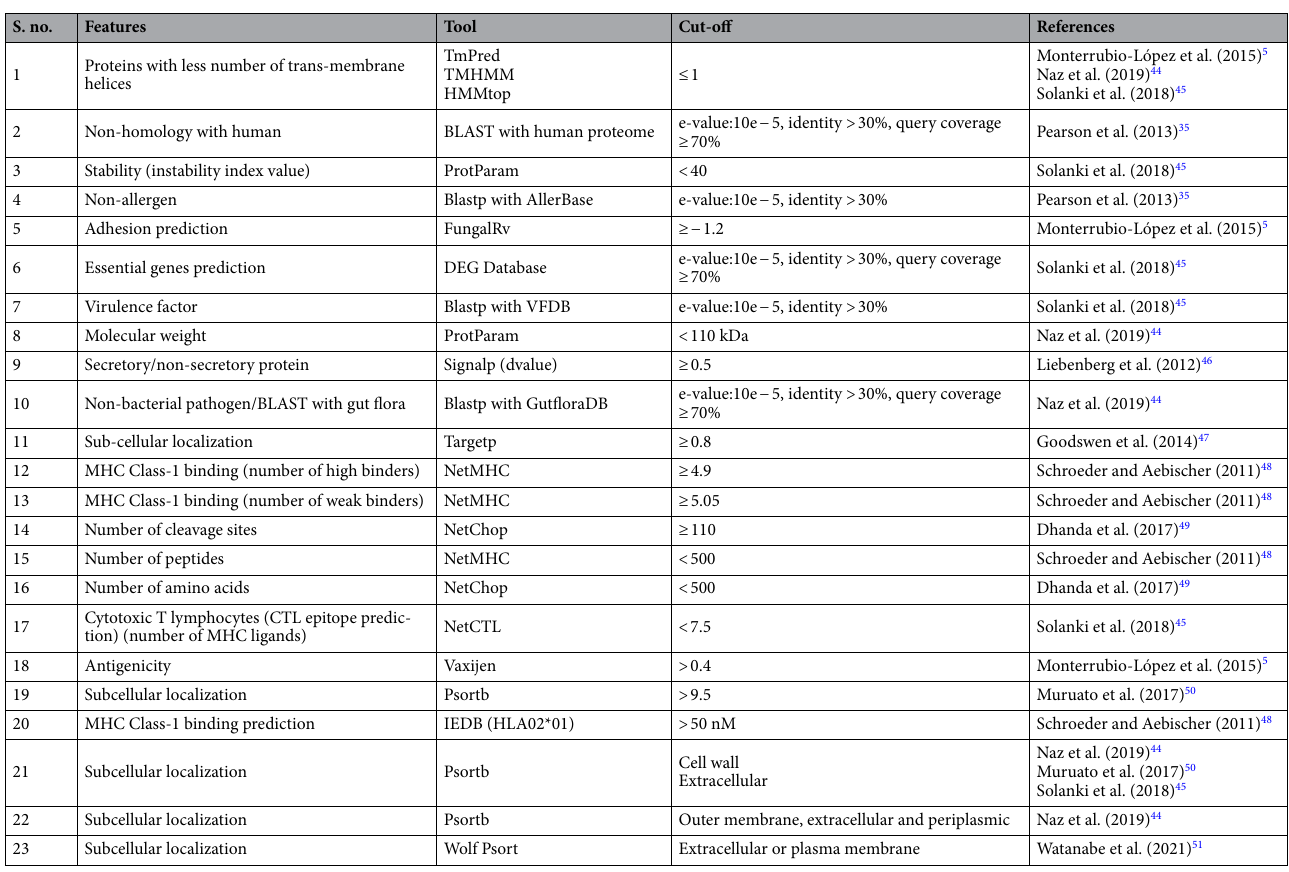
Table 1. Tools used for extraction of features along with their cut-off